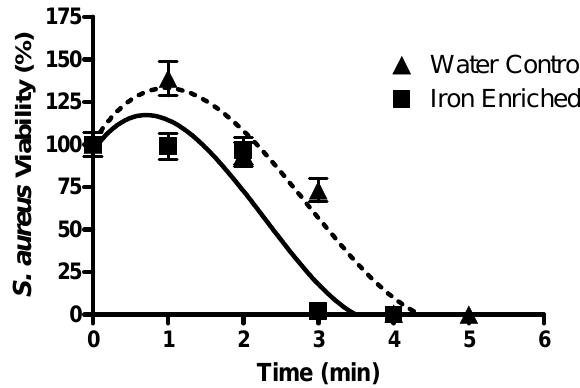
Figure 5: Effect of iron ions on microwave disinfection of S. aureus. Illustrates the effect that iron ions (solid line) have on the deactivation of S. aureus (n=10) during microwave heating compared to a distilled water control (dotted line). Similar to E. faecalis , iron ions had a negligible effect on microwave disinfection of S. aureus .